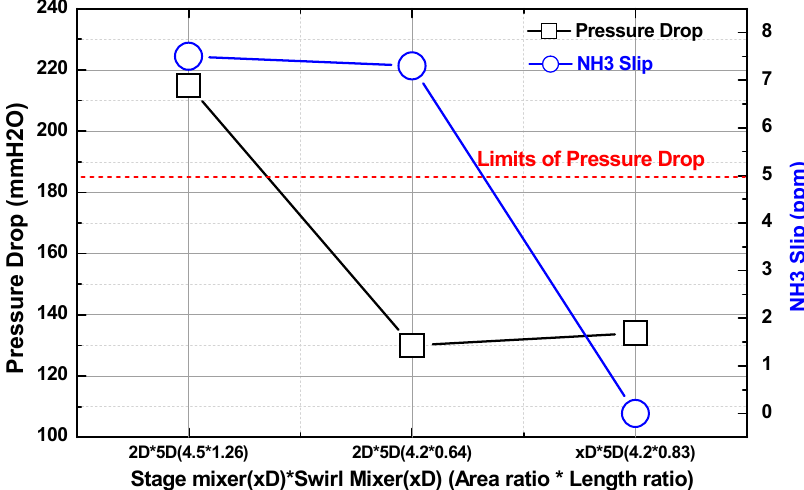
Figure 9. Pressure decrease and NH 3 slip characteristics in relation to mixer type and mixer location.